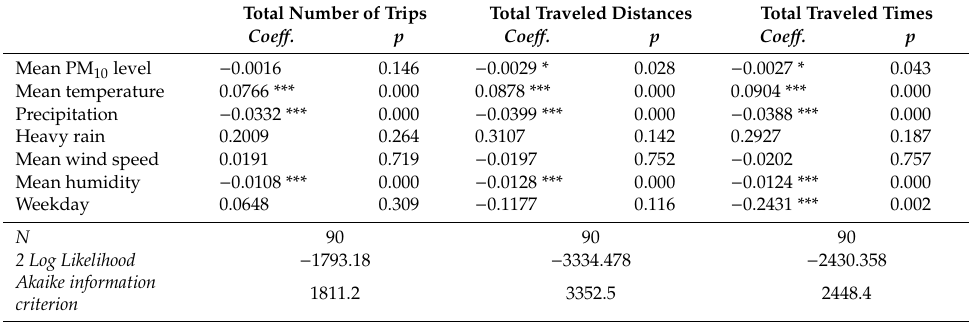
Table 5. Estimation results for bike sharing use using PM 10 level data in